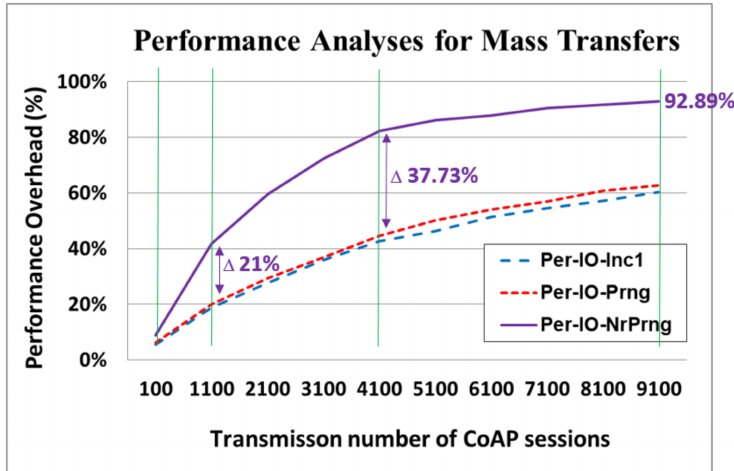
Figure 15. Performance analyses for mass data transfers among different key update